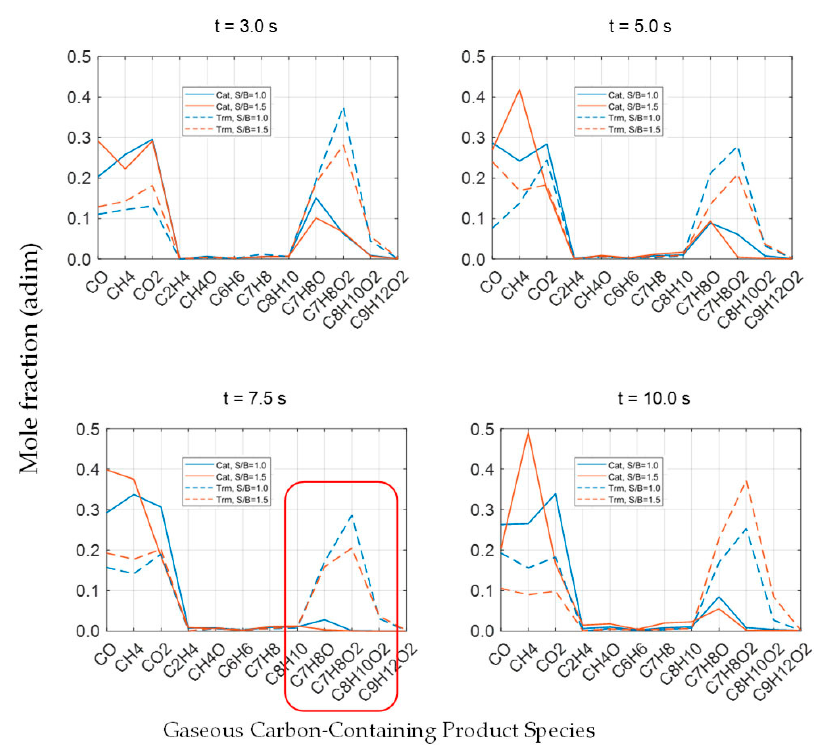
Figure 11. Carbon-containing product species distribution for catalytic and thermal runs at 500 °C, S / B = 1.0 and 1.5, and at four reaction times, 3 s, 5 s, 7.5 s, and 10 s. Note: the red rectangle for 7.5 s highlights the C7–C9 fractions.